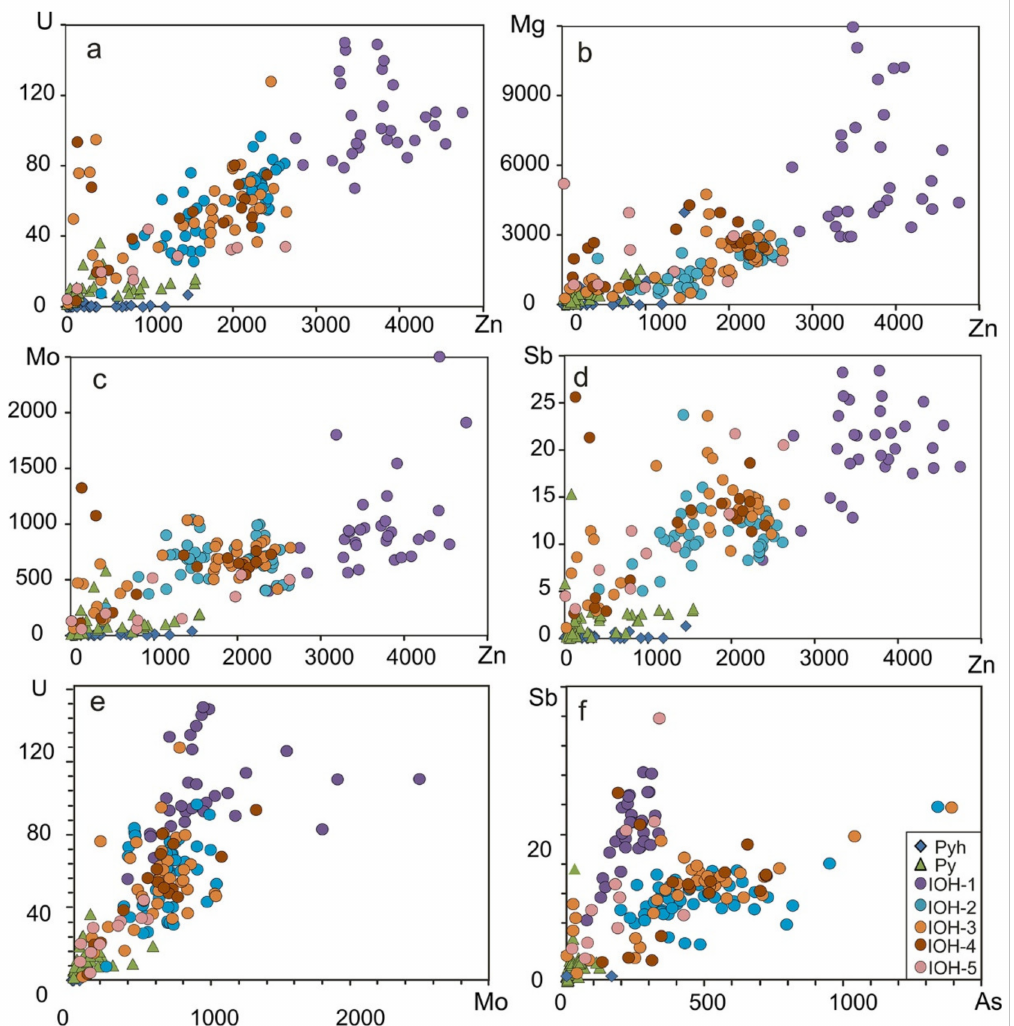
Figure 6. Bivariate plots of: ( a ) Zn vs. U; ( b ) Zn vs. Mg; ( c ) Zn vs. Mo; ( d ) Zn vs. Sb; ( e ) Mo vs. U and ( f ) As vs. Sb for iron oxyhydroxides (IOH), pyrite (Py) and pyrrhotite (Pyh) of the Pobeda-1 hydrothermal field